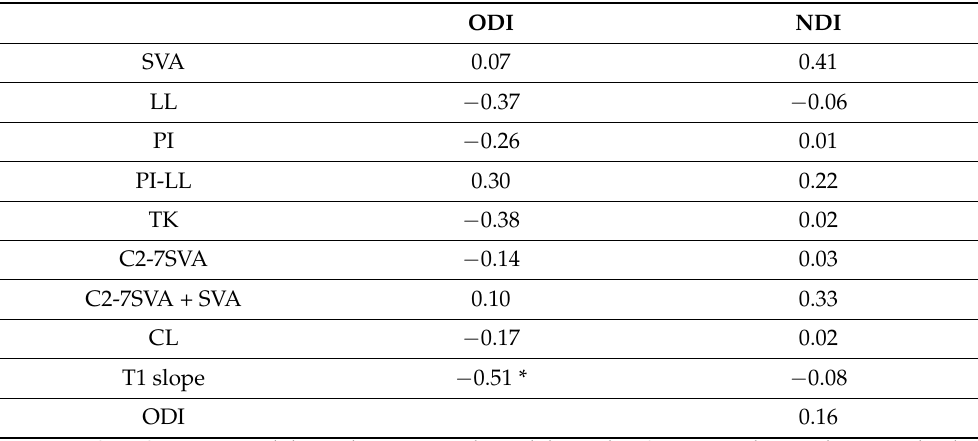
Table 6. Association between radiographic parameters and ODI/NDI score using Spearman’s correlation among non-farmers. ODI NDI SVA − 0.03 − 0.03 − 0.16